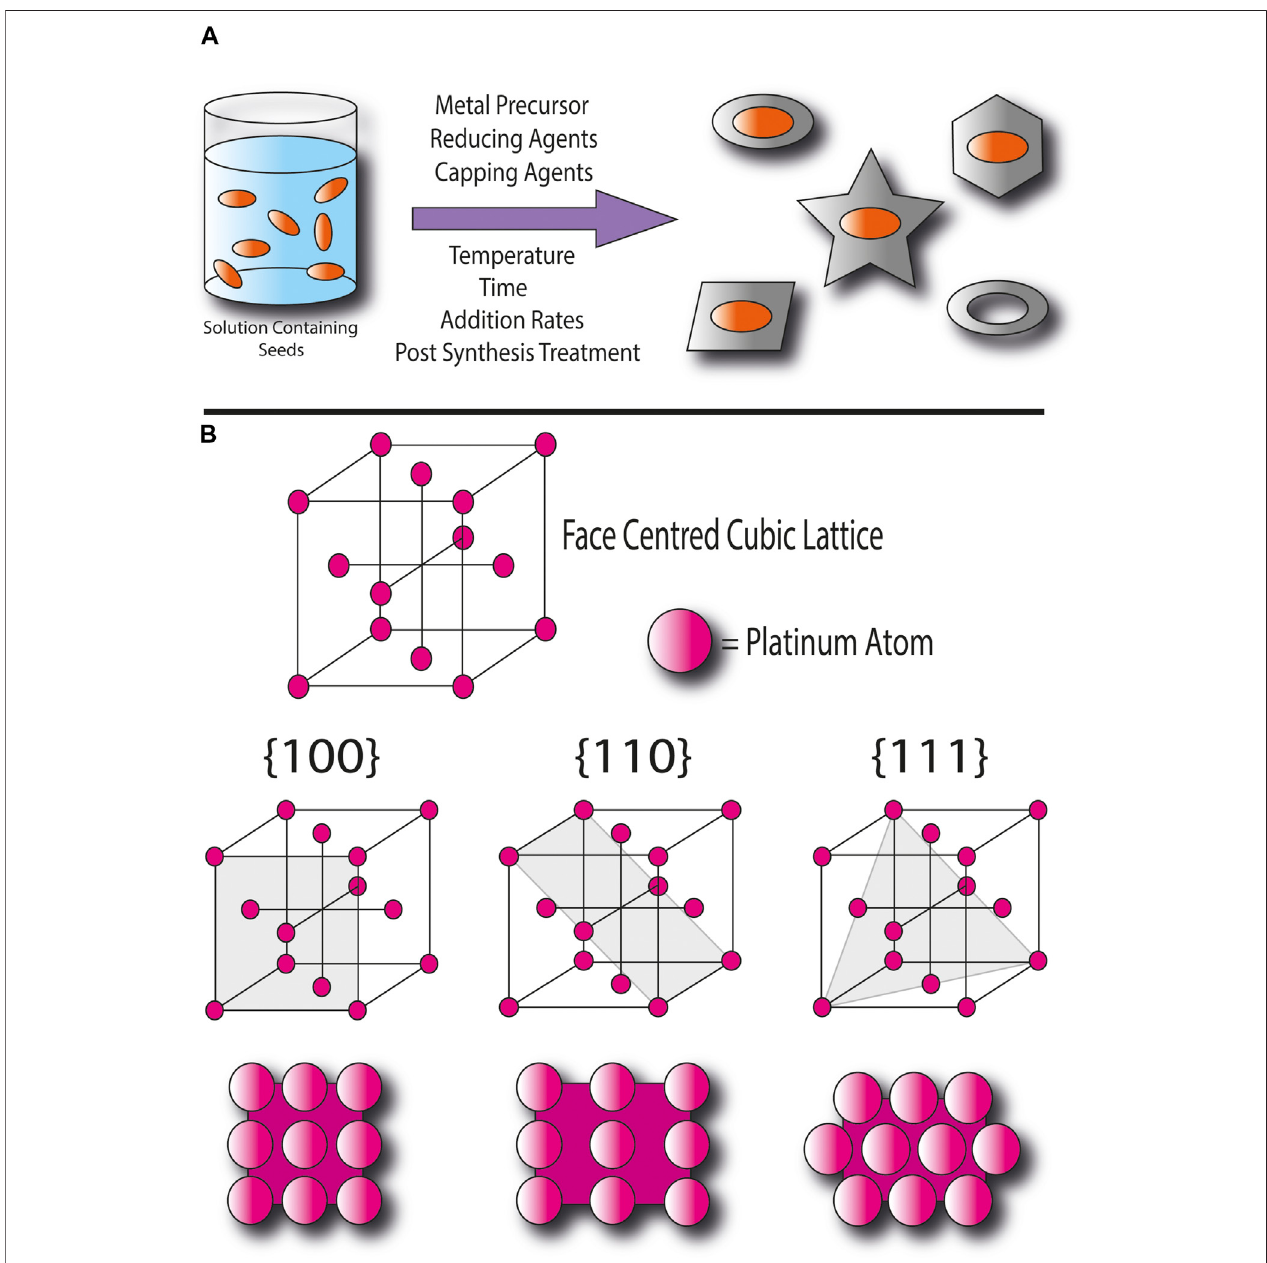
FIGURE 1 | (A) Illustration of the general procedure of seed-mediated synthesis to produce different nanocrystal shapes, (B) Illustration of platinum ’ s face centred cubic lattice and its {100}, {110}, and {111} facets.